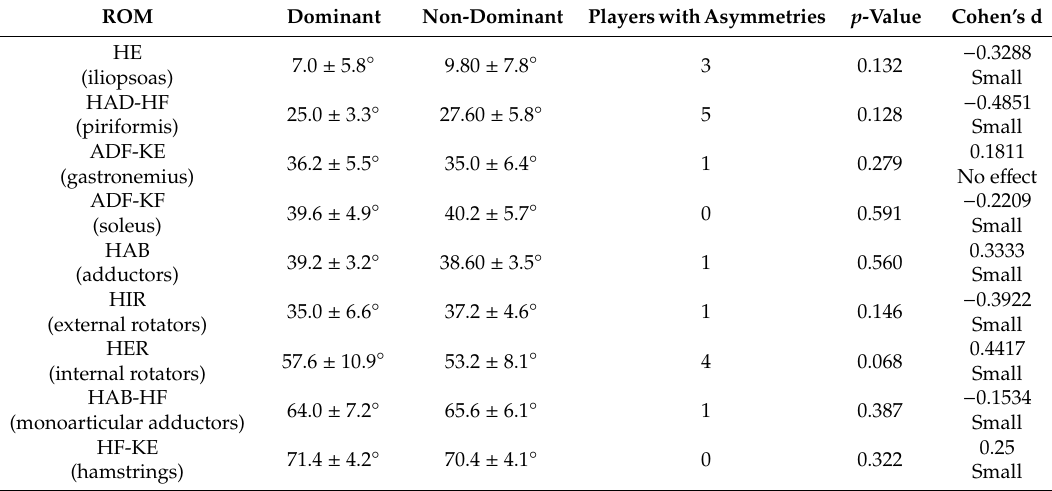
Table 3. Passive maximum range of motion values of 10 inline hockey players of the Spanish elite male team.